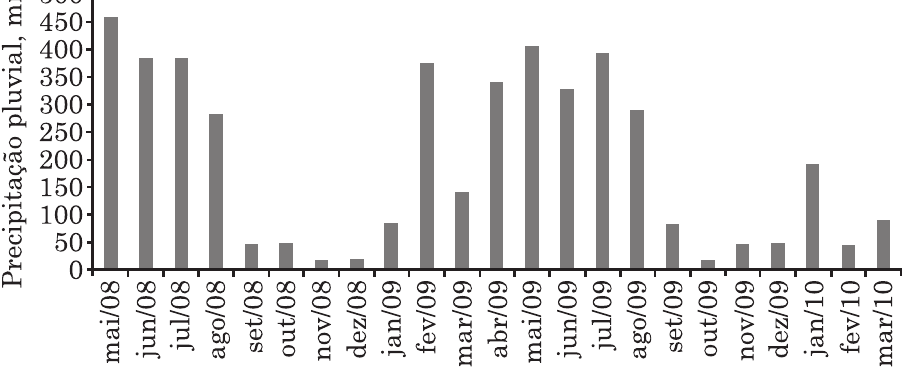
Figura 1. Precipitação pluvial mensal da estação experimental do IPA (Itambé, PE) no período compreendido entre as coletas de solo para caracterização inicial e avaliação da fertilidade. Fonte: ITEP